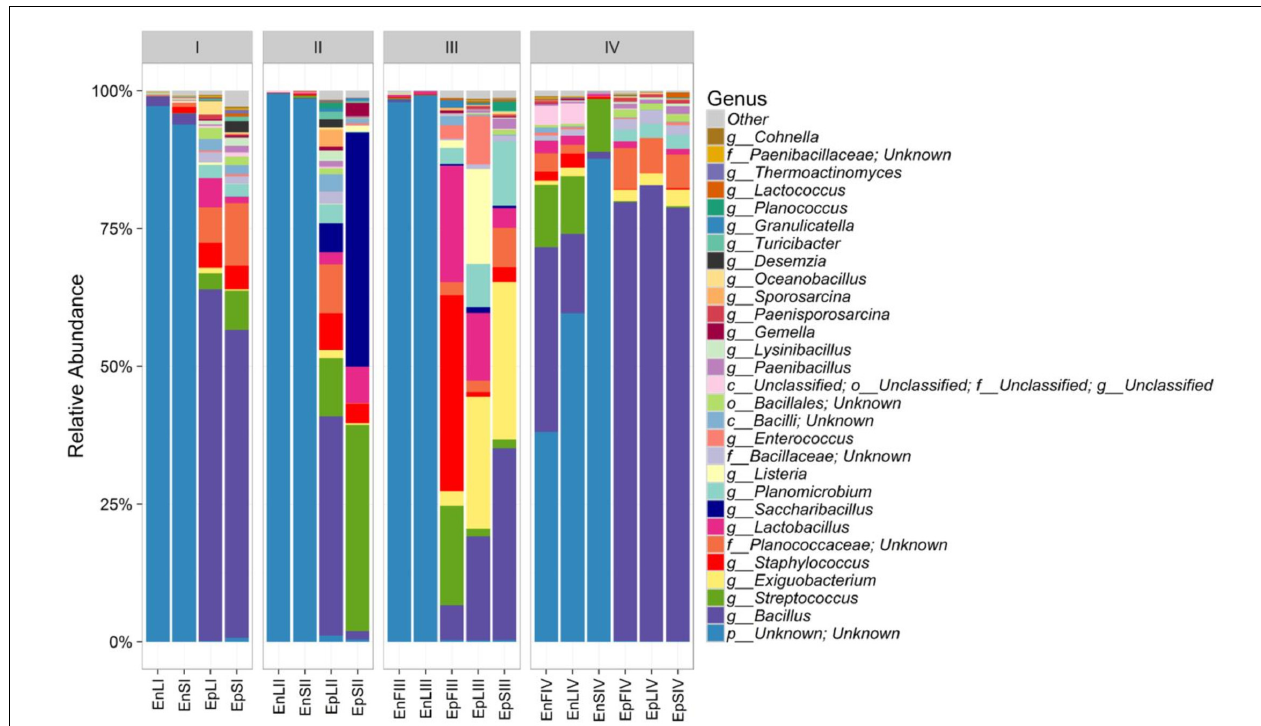
FIGURE 5 | Relative abundance of epiphytic (Ep) and endophytic (En) Firmicutes genera found on leaves (L), stems (S) and flowers (F) of Origanum vulgare L. plant during the early vegetative (I), late vegetative (II), blooming (III) and full-flowering (IV)